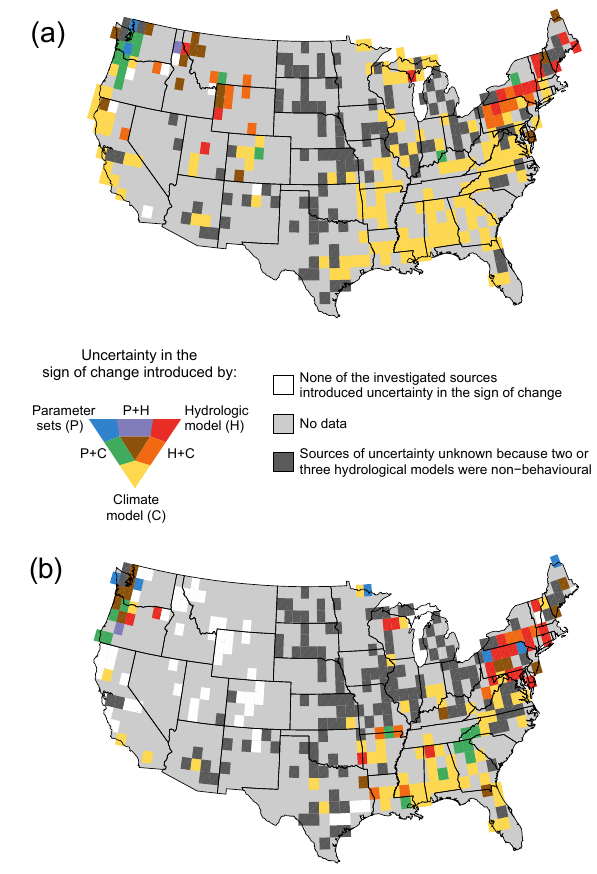
Figure 9. Distribution of the combined investigated sources of un- certainty for (a) mean runoff and (b) discharge timing. Spatial cov- erage is obtained by determining a grid-based (1 ◦ × 1 ◦ ) maximum likelihood; see Sect. 2.6. Results for different GCM–hydrologic model combinations can be found separately in Figs. A4 and B4. Note that three important sources of uncertainty have not been in- vestigated in this study: internal climate variability, emission sce- narios, and the statistical downscaling technique for GCM